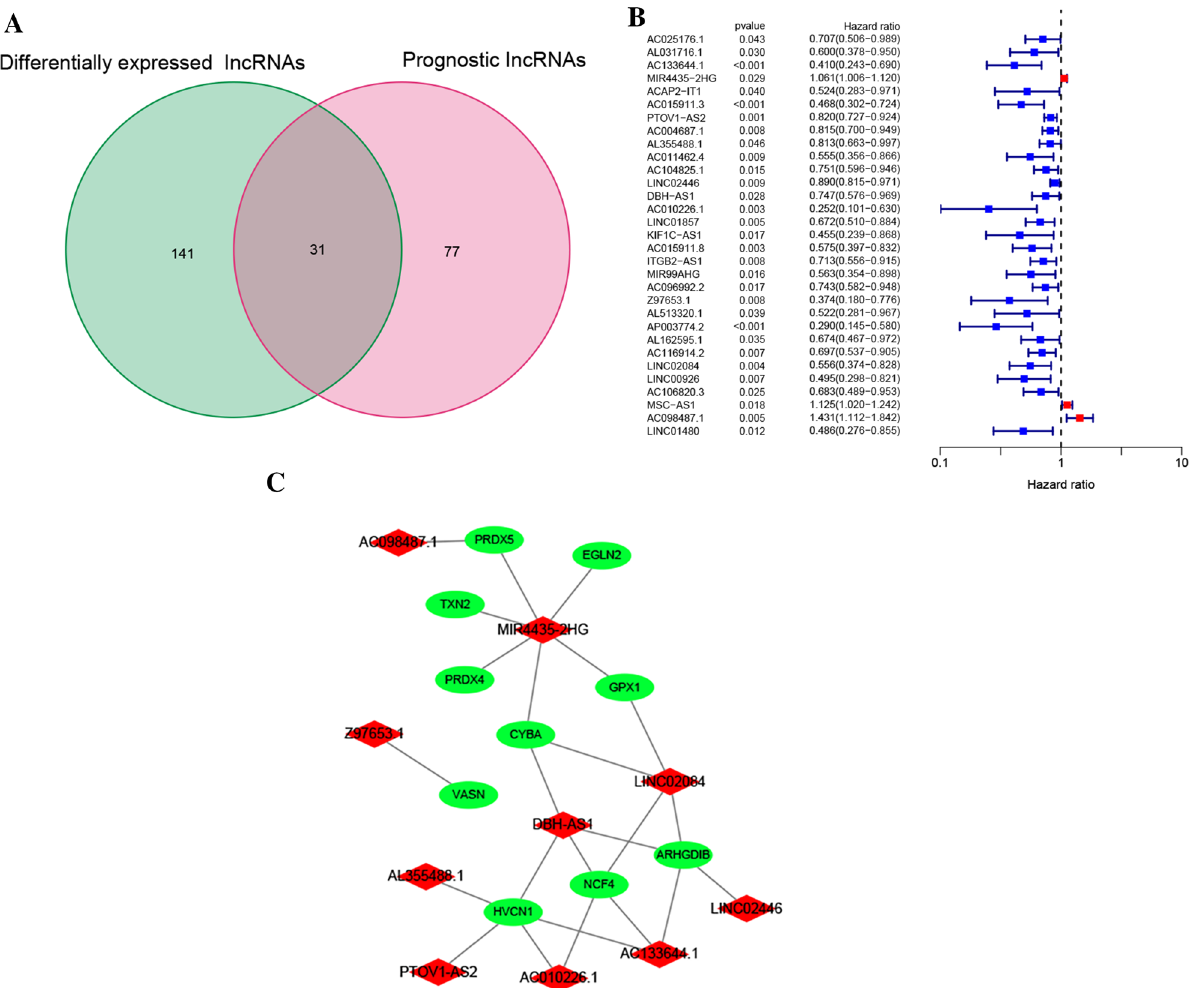
Figure 2. Identification of the rrlncRNAs. ( A ) The 31 overlapped rrlncRNAs extracted from the 172 differentially expressed rrlncRNAs and 108 prognostic rrlncRNAs. ( B ) Univariate Cox analysis of 31 rrlncRNAs in HNSCC. ( C ) The relationship network between identified rrlncRNAs and relevantly co-expressive